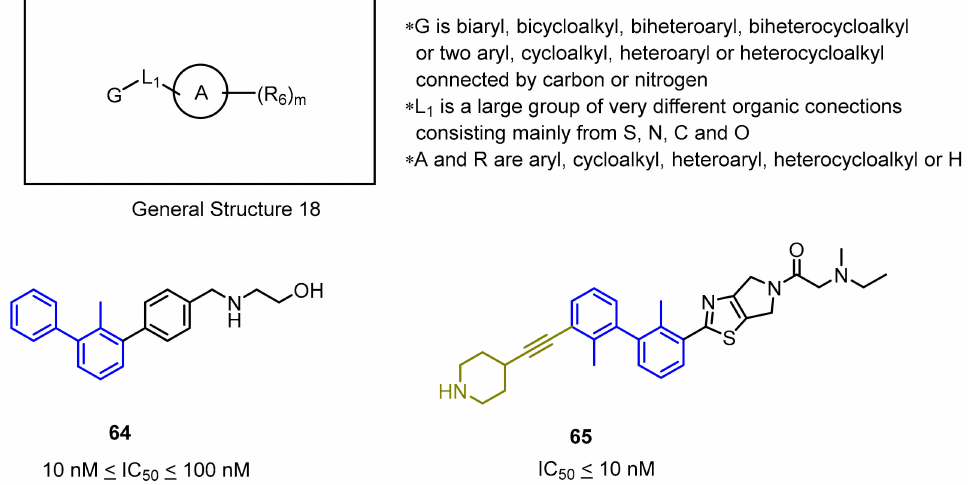
Figure 27. General structure and examples of the PD-1 / PD-L1 inhibitors patented by Incyte Corporation ( 64 and 65 ). The 3 (cid:48) biphenyl’s substituent is depicted in gold. ChemoCentryx has identified 4-phenyl-2,3-dihydro-1 H- inden-1-ol derivatives as inhibitors of